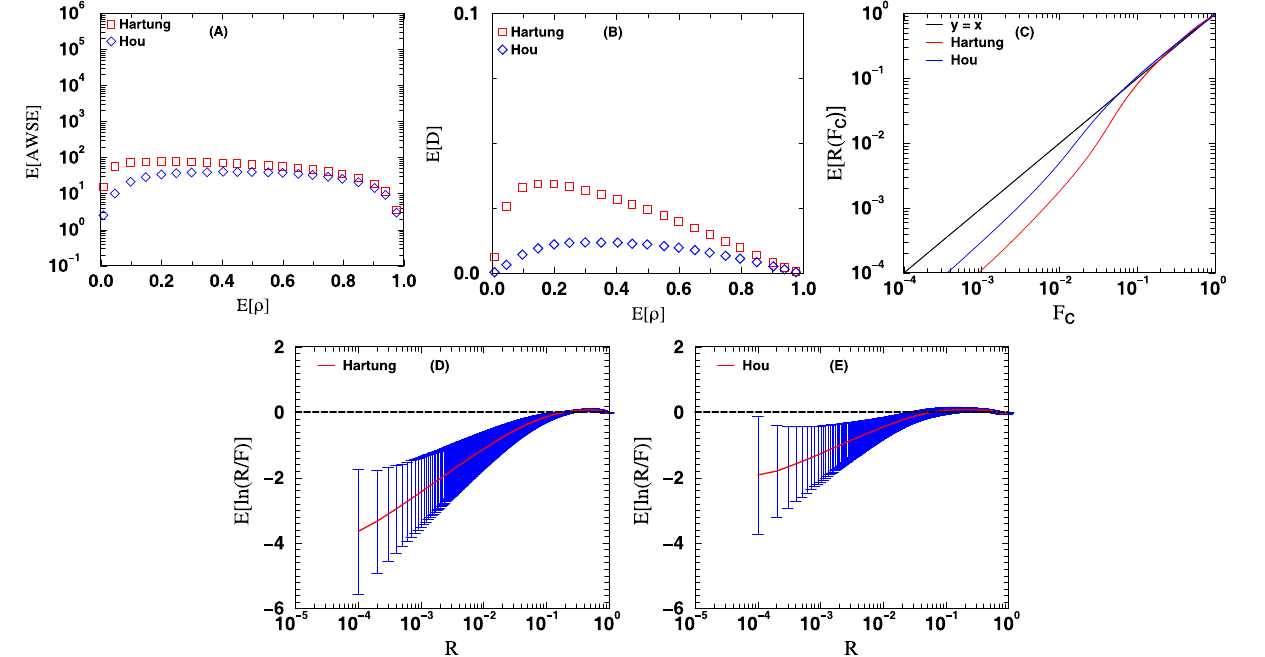
Figure 5. Methods that combine correlated P -values: Hartung and Hou. The curves plotted above are the curves for the four different measures used to evaluate the accuracy of the computed P -value from combining the P -values of 12 P -value vectors. See text for more details.